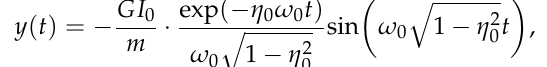
Figure 20. Graph of free damping motion under different excitation of currents.